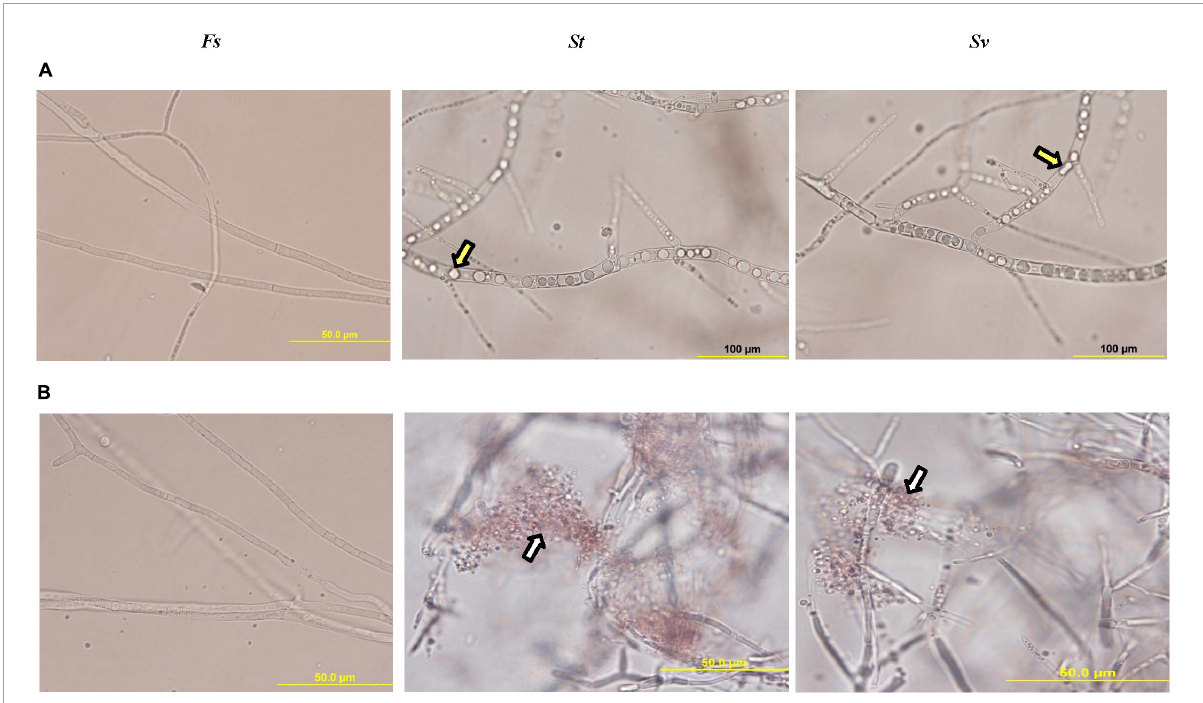
FIGURE5 Inhibitory effect of the metabolites of BCA candidates on Fusarium solani . Abnormalities evident in the hyphal morphology and cytoplasmic contents of F. solani , following the treatment with filter-sterilized crude culture filtrate on (A) FMEB or (B) CCB of St (middle panel) and Sv (right panel) compared to control (left panel). Yellow arrows point to hyphal non-septate formation and cytoplasmic coagulation, while white arrows point to cytoplasmic lysis; respectively. St , the ACCD-non-producing Streptomyces tendae UAE1 (BCA1; isolates #6); Sv , the ACCD-producing Streptomyces violaceoruber UAE1 (BCA2; isolate #26); BCA, biological control agent; FMEB, fish meal extract broth; CCB, colloidal chitin broth. Light microscopy images were taken at 1,000 times total